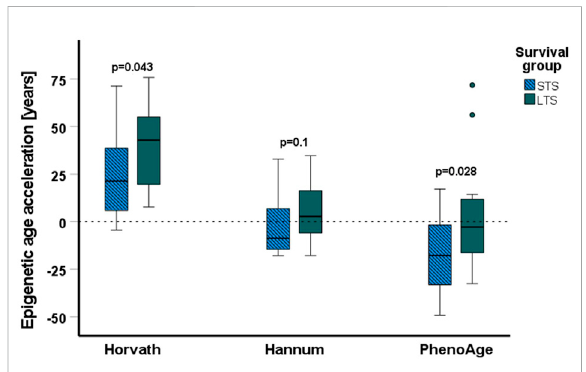
FIGURE 5 Results of the epigenetic age acceleration analyses. The epigenetic age acceleration (difference between the epigenetic age and the chronological age) is shown in years on the y -axis, horizontal lines represent the median values, boxplots represent the fi rst and third quartiles, errors arerepresented bythe T-bars, and the dots represent outliers. Epigenetic age acceleration is signi fi cantly lower for short-term survivors (STS) ( N = 18) than long-term survivors (LTS) ( N = 18) when calculated with Horvath ’ s and PhenoAge algorithms. All data above the dashed line represent an acceleration of epigenetic age, and data below the dotted line represent a deceleration of epigenetic